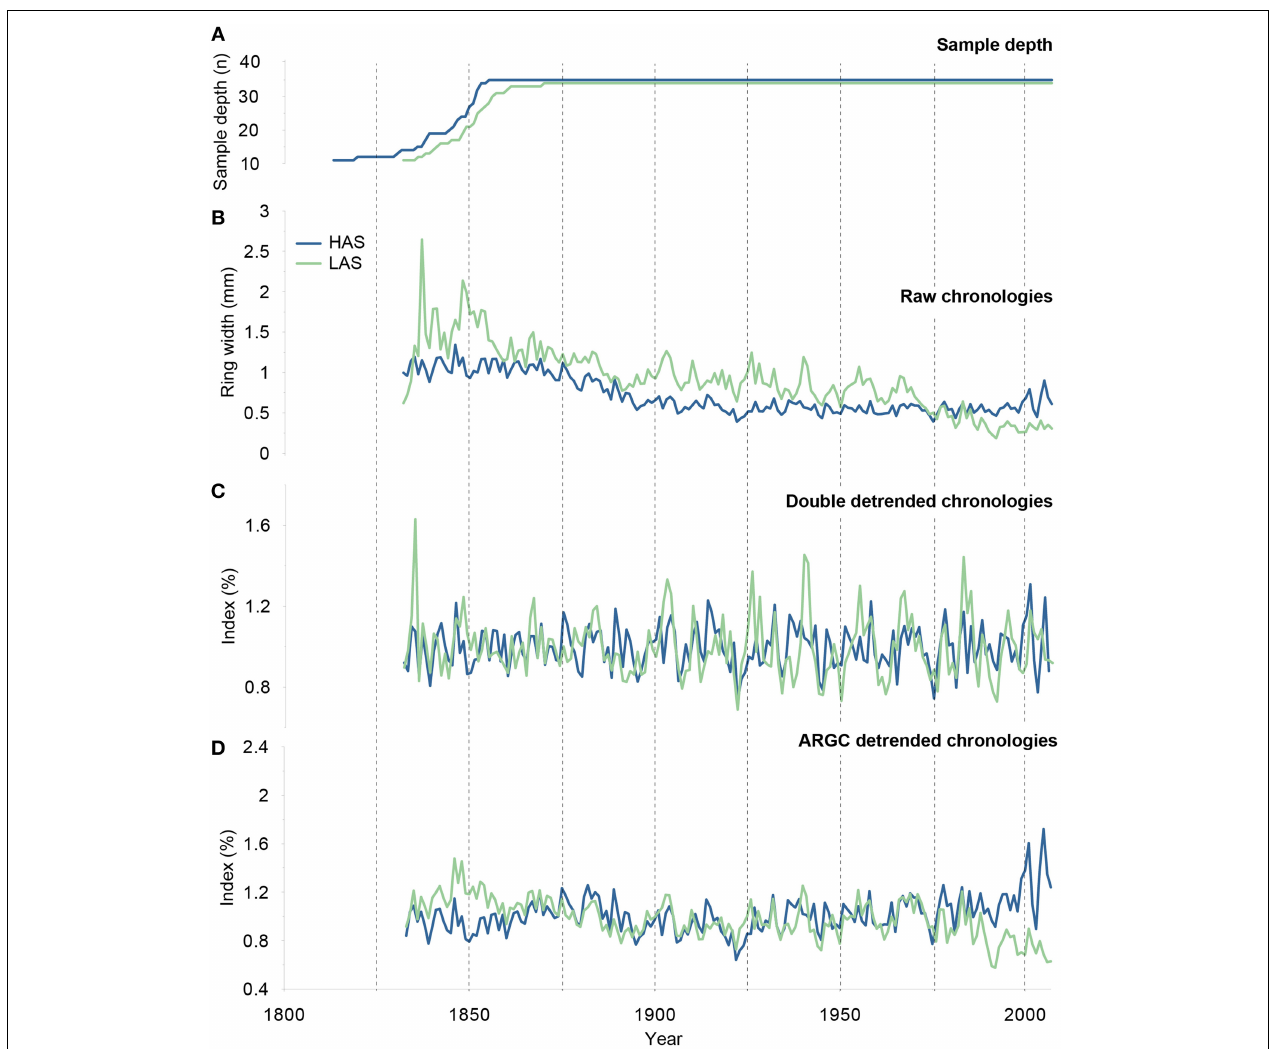
FIGURE 2 | (A) Sample depth ( = number of trees included in chronologies), (B) Raw ring width, (C) double detrended and (D) ARGC detrended chronologies of Pinus uncinata from the low (LAS, green) and high (HAS, blue) altitude